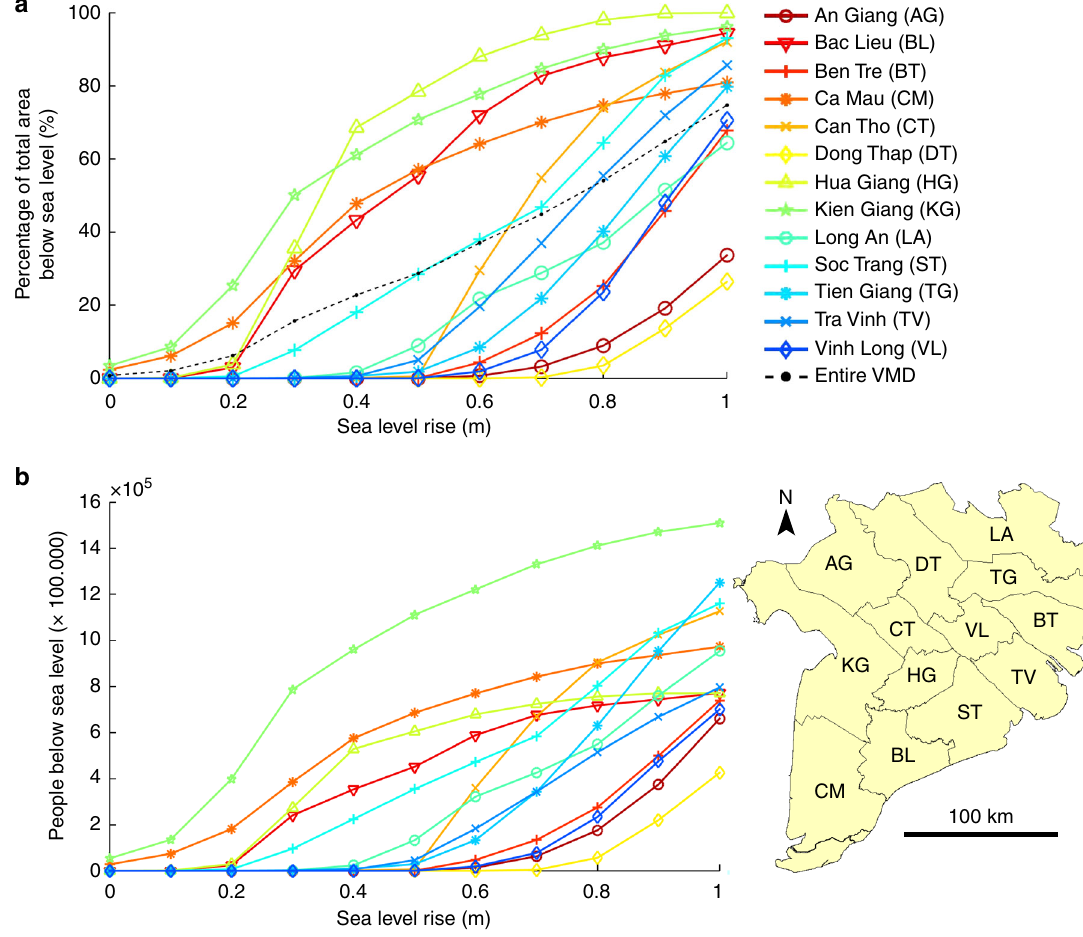
Fig. 6 Area and estimated number of inhabitants affected by sea-level rise. Delta area ( a ) and estimated number of inhabitants ( b ) below sea level following sea-level rise up to 1 meter based on the Topo digital elevation